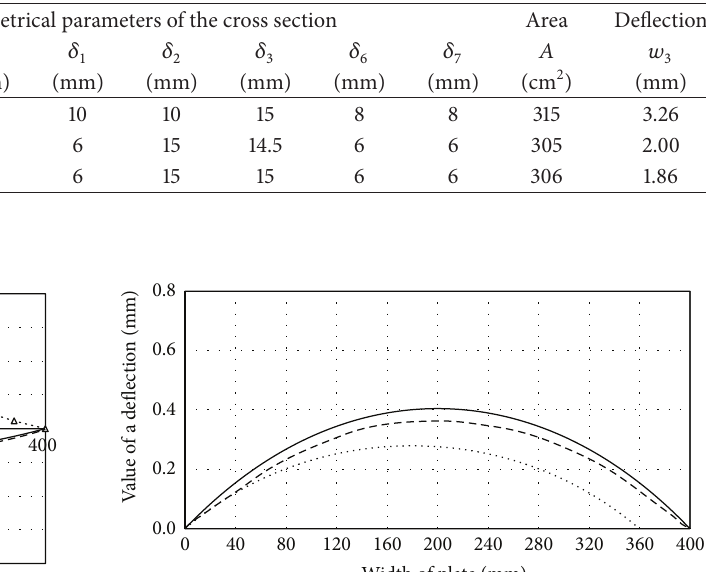
Table 2: Comparative analysis of influential box girder parameters.